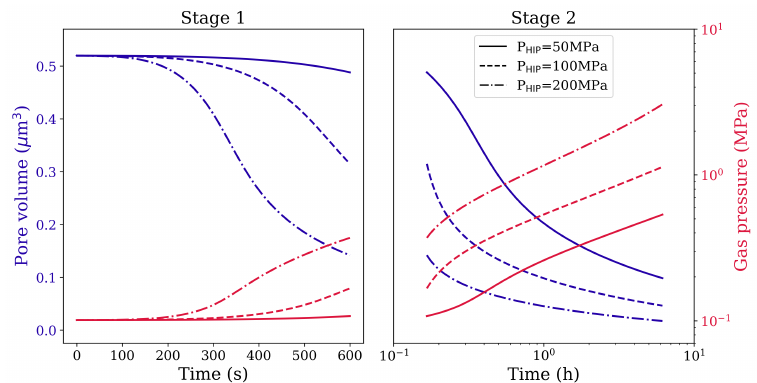
Figure 6. Pore volume reduction and gas pressure evolution in Stage 1 and Stage 2 HIP loading for spherical pore of radius 1 µ m under different magnitudes of the isostatic pressure and different holding times at 1561 K.